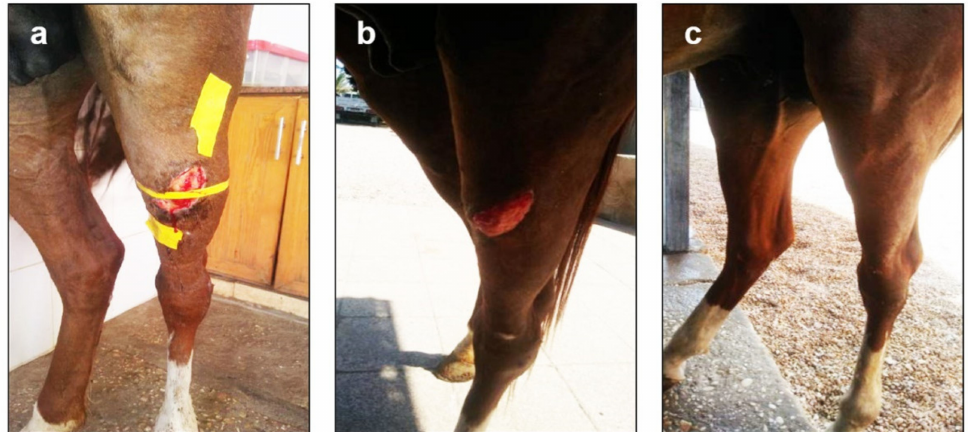
Figure 8. ( a ) Nine-year-old horse with recent wound at the left hind limb, the wound was divided into two parts and treated with and treated with gel (1) S. arghel EtOAc gel and gel (2) S. arghel MeoH extract gel. ( b ) The same animal, after 18 days of treatment, showed decreased wound size and complete epithelization with hypergranulation tissue due to the wound being near a movable part. ( c ) The same animal, after a month and a half, showed complete wound